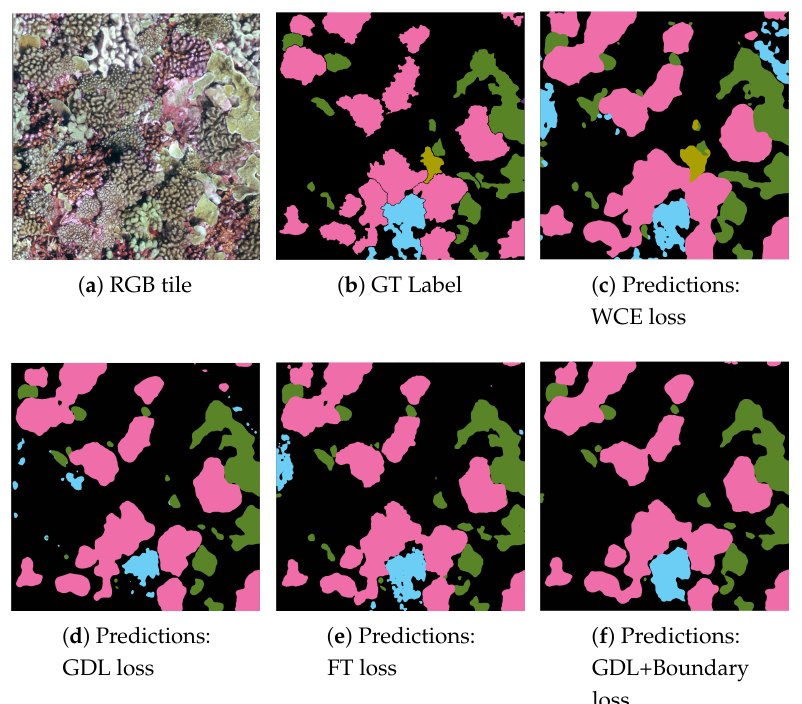
Figure 4. A dense coral coverage dataset tile ( a ) and the corresponding predicted labels ( b – f ). The Deeplab V3+ model has been fine-tuned using the same hyperparameters but minimizing different loss function. The model minimizing the WCE loss produces predictions with smoother contours and a high number of false positives. Nevertheless, the model that uses the WCE is the only one which correctly spots the colony of encrusting Montipora . The introduction of FT significantly improves the accuracy at instance boundaries. The use of GDL+Boundary loss penalizes the prediction of small colonies; some of the them are incorrectly classified as Background .